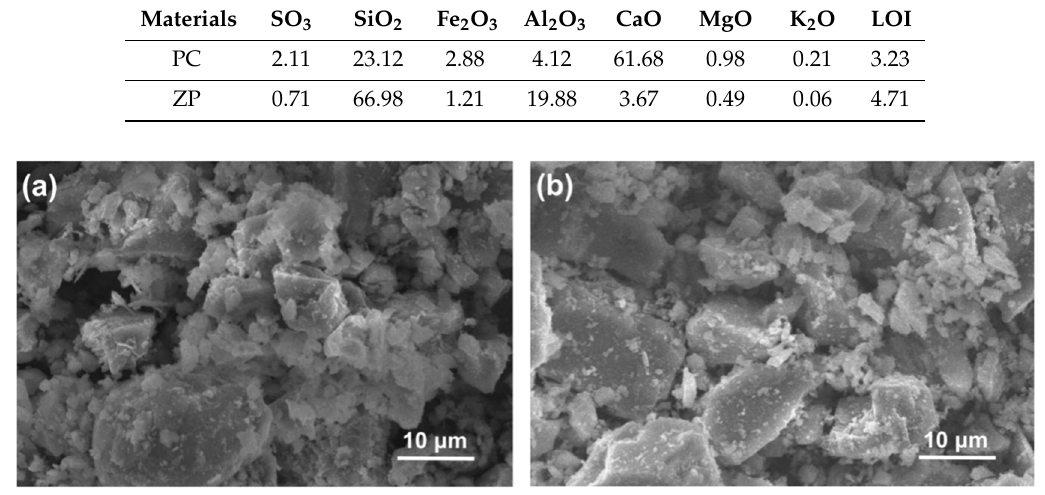
Figure 1. SEM images of ( a ) PC and ( b ) ZP.